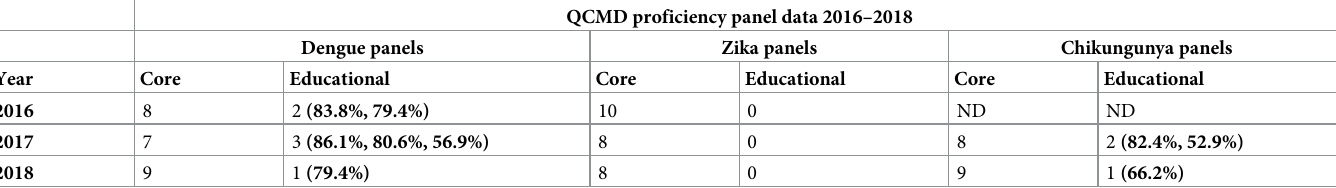
Table 4. Results of the 2016–2018 QCMD proficiency panels.